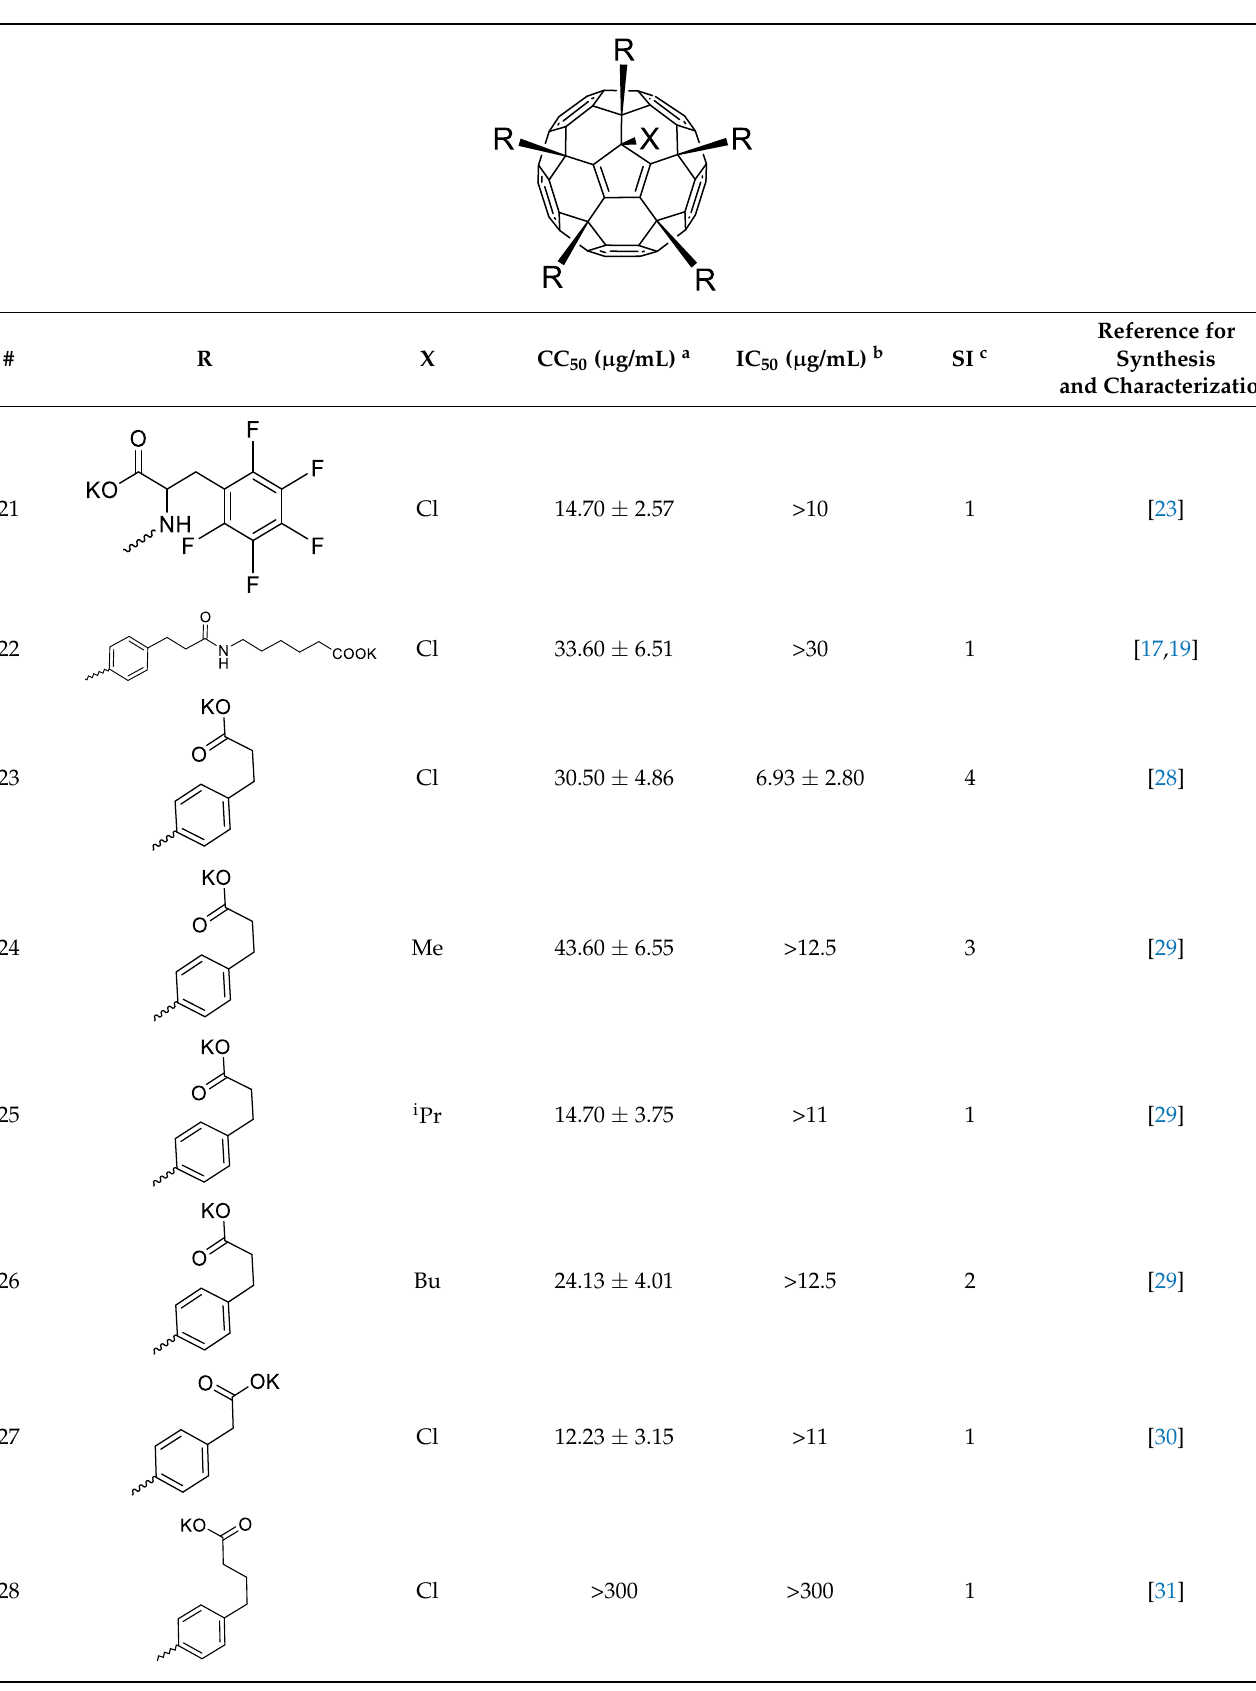
Table 1. Antiviral activity of the water- soluble fullerene derivatives against Influenza А/Puerto Table 1. Cont. Rico/8/34 (H1N1) virus in MDCK